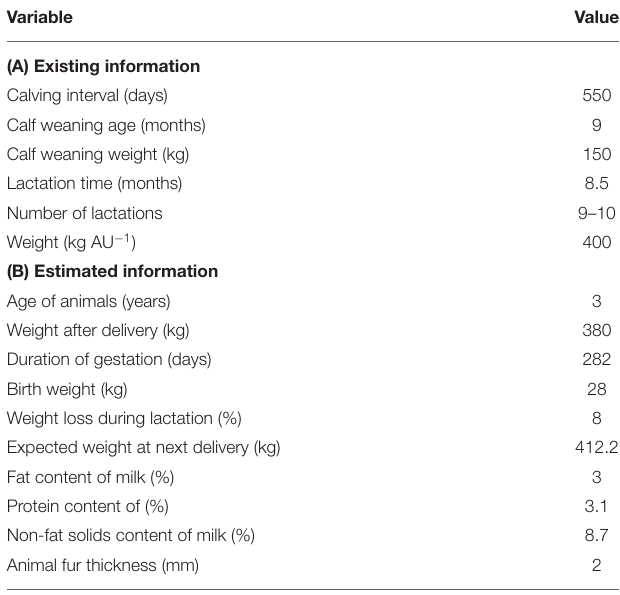
TABLE 3 | LIFE-SIM model inputs for the animal